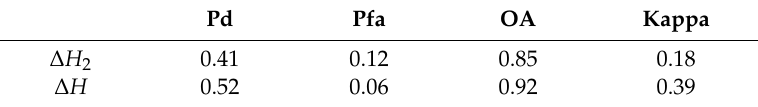
Table 3. Detection accuracies for the di ff erent polarimetric